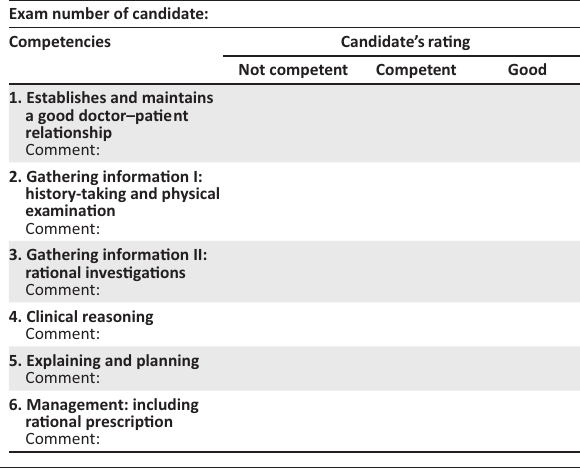
FIGURE 1: Marking template for consultation